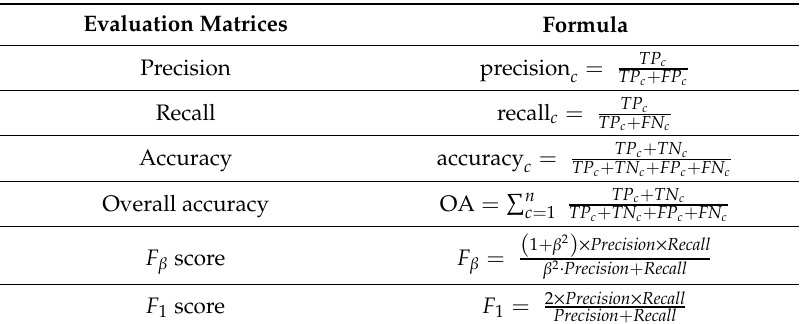
Table 5. Evaluation matrices with associated